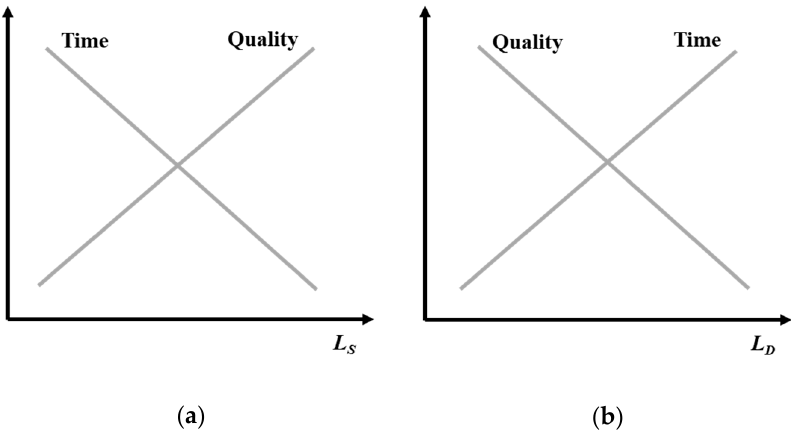
Figure 1. Relationship between working time/quality and; ( a ) level of skill ( L S ); ( b ) level of difficulty ( L D ).